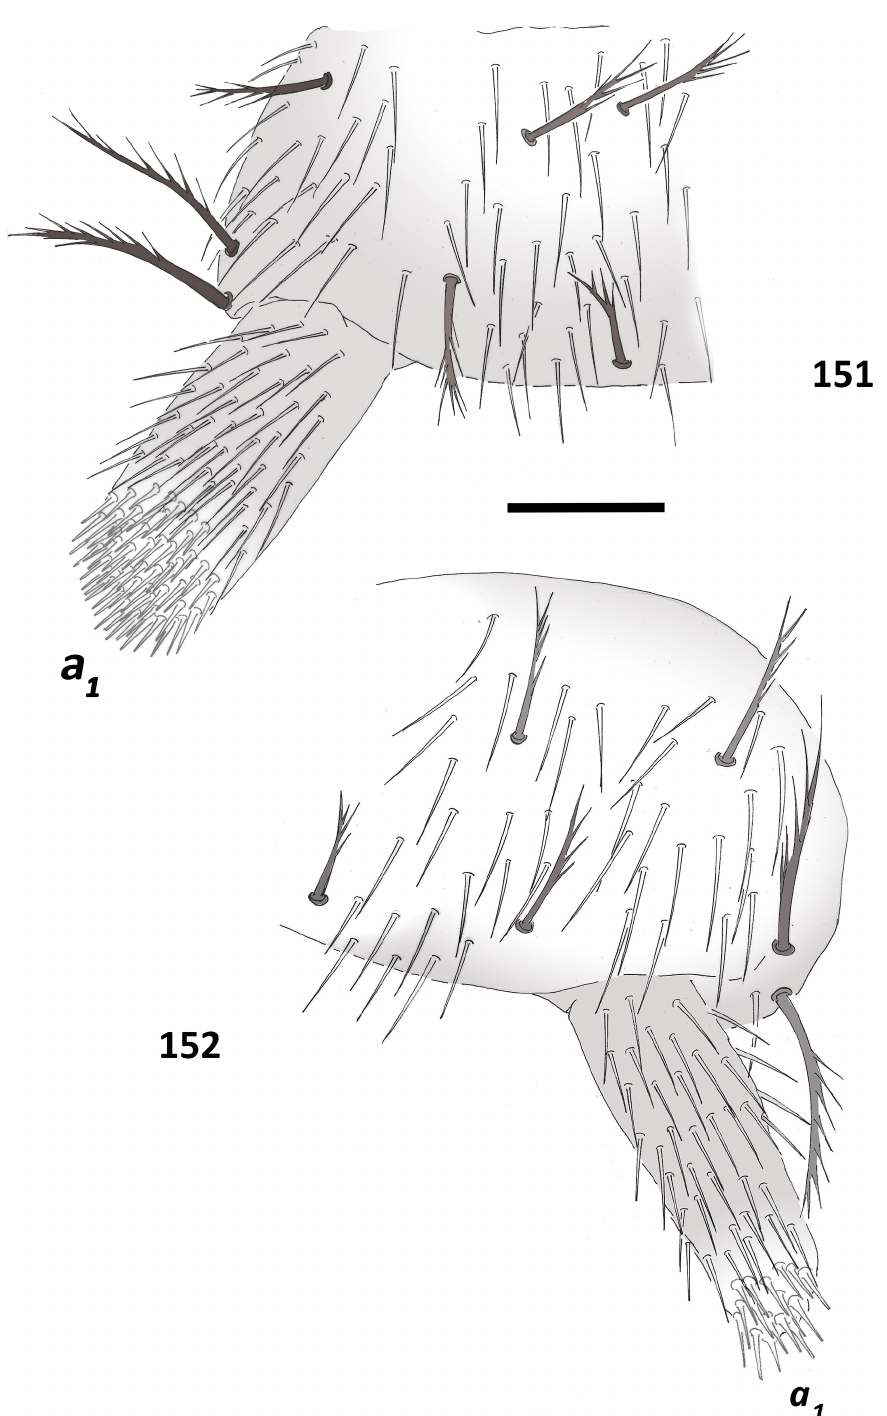
Figs 151–152. Plusiocampa ( Plusiocampa ) strouhali cavicola Vornatscher, 1943, from Odelsteinhöhle, Styria, Austria (Coll. AS). 151 . ♂, 6.3 mm long; urosternite I, right side. 152 . ♀, 6.3 mm long; uro- sternite I, left side. Scale bar: 0.1